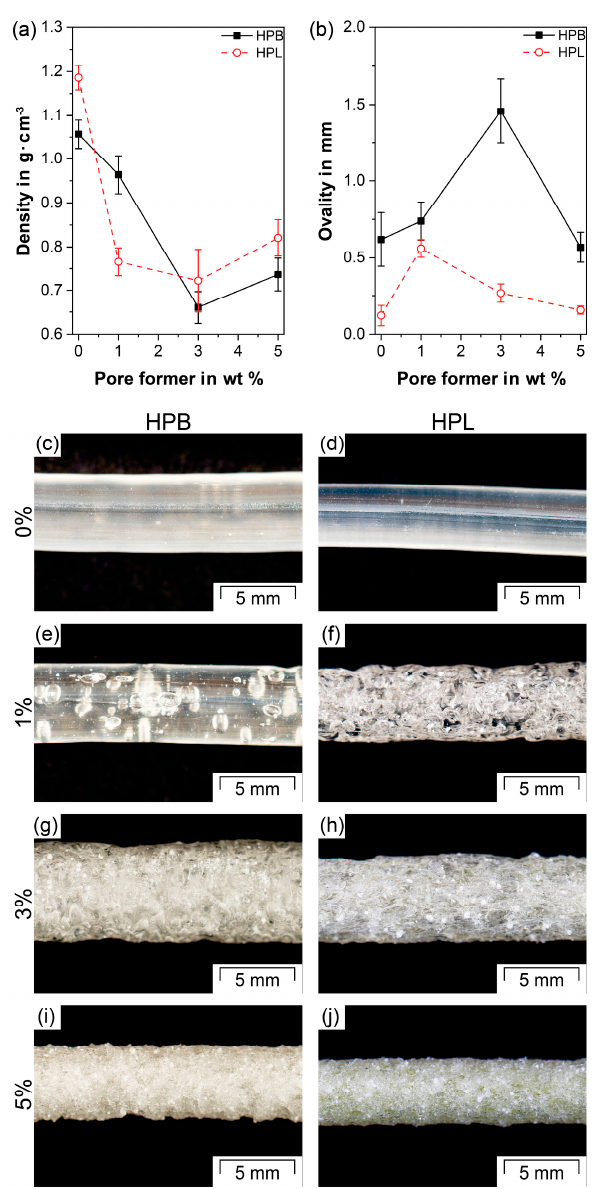
Figure 2. ( a ) Apparent density, ( b ) ovality and ( c – j ) macroscopic images of formulations comprising hydrophobic (HPB) and hydrophilic thermoplastic polyurethane (HPL) with and without NaHCO